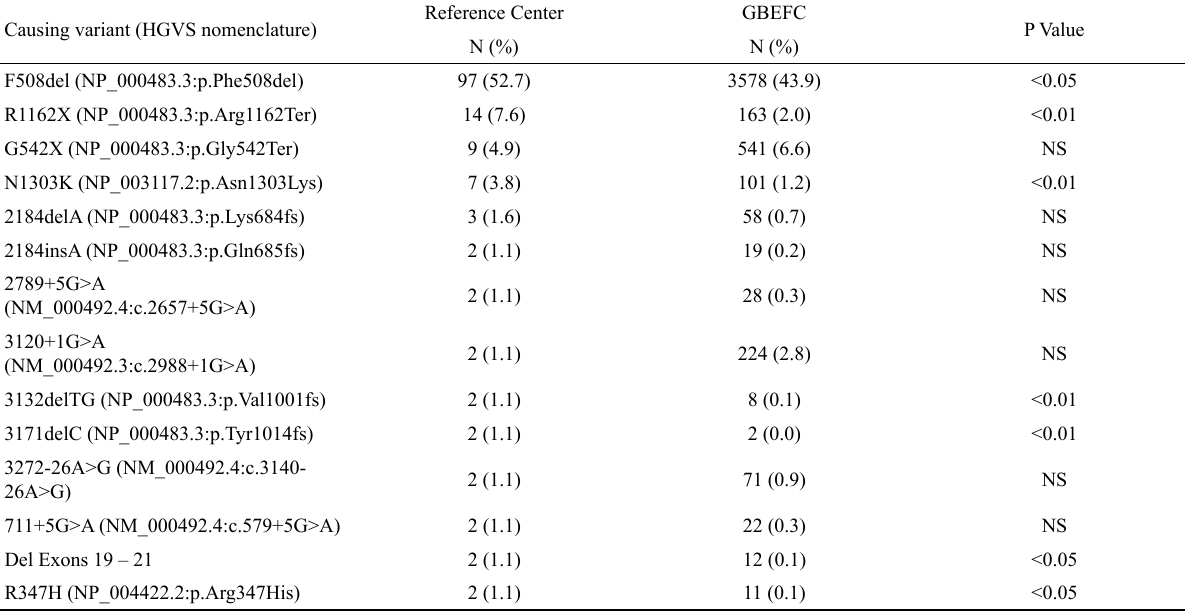
Table 2 – Comparison between the prevalence of alleles for the most frequent causing variants in the CF Reference Center at São Lucas Hospital - PUCRS and Brazilian Registry of CF. Causing variant (HGVS